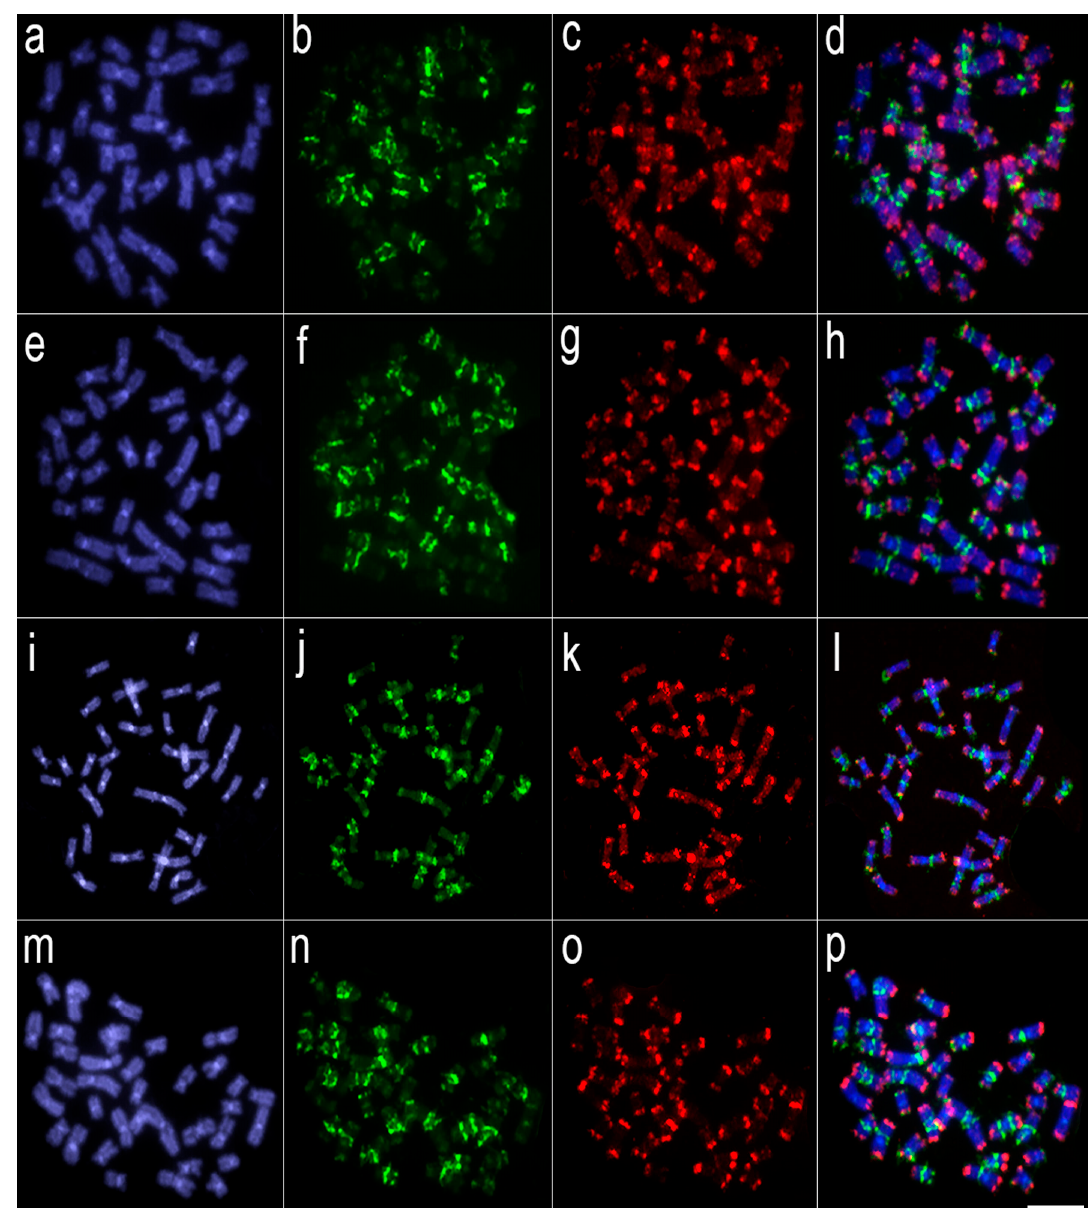
Figure 4. Comparative genomic hybridization using the gDNA of Lebiasina melanoguttata and Pyrrhulina species against a chromosomal background of Lebiasina melanoguttata . Genomic probes from L. melanoguttata and P. australis hybridized against L. melanoguttata chromosomes ( a – d ). Genomic probes from L. melanoguttata and Pyrrhulina aff. australis hybridized against L. melanoguttata chromosomes ( e – h ). Genomic probes from L. melanoguttata and P. brevis hybridized against L. melanoguttata chromosomes ( i – l ). Genome from L. melanoguttata and P. semifasciata hybridized against L. melanoguttata chromosomes ( m – p ). The first column ( a , e , I , and m ): DAPI images (blue); second column (b, f, j, and n): hybridization patterns using gDNA probe from L. melanoguttata ; third column ( c , g , k , and o ): hybridization patterns using gDNA probes from P. australis , Pyrrhulina aff. australis , P. brevis, and P. semifasciata , respectively; fourth column ( d , h , l , and p ) merged images of both genomic probes and DAPI staining, depicting the shared regions in yellow. Scale bar = 5 μ m.